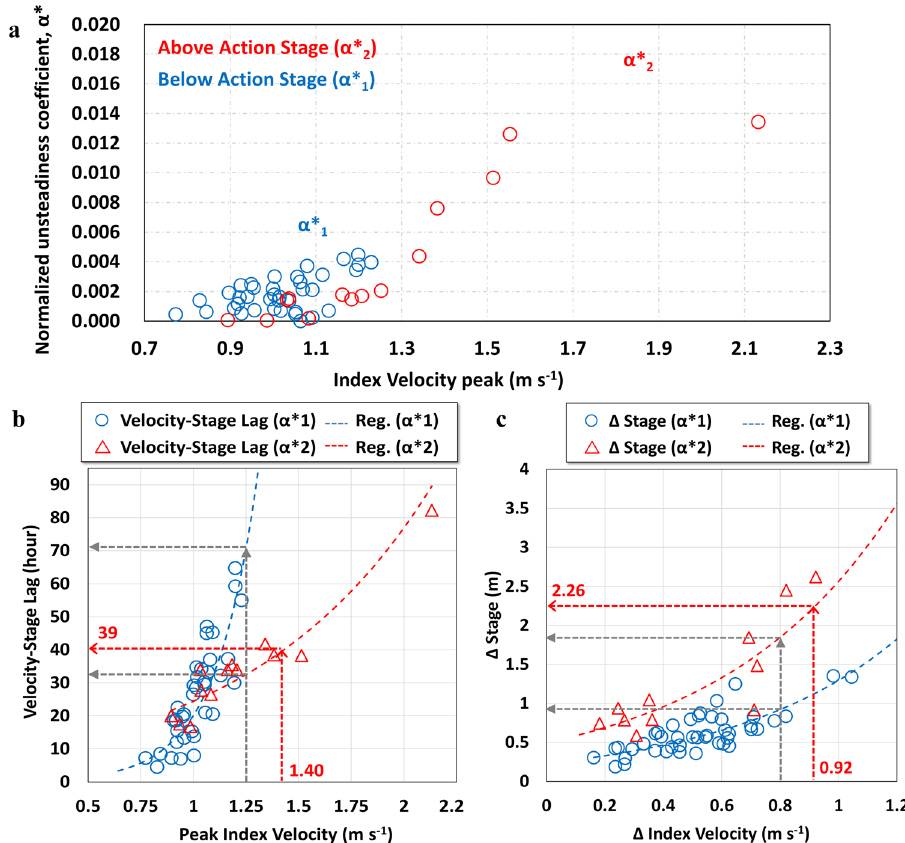
Fig. 4 Construction and usage of the fl ood wave crest amplitude and arrival time forecasting protocol. a Unsteadiness coef fi cients for the pulses in the training dataset grouped by warning severity levels. b Regression lines for the index velocity peak and the corresponding lag times in the stage progression response grouped by warning severity levels. c Regression lines for the gradients of index-velocities and stages to their peaks grouped by warning level severity. Note: red dotted straight lines display forecasted values based on the status of the parameters at the start of storm pulse #50 (see Table 4). Supplementary data to generate Fig. 4 are included in Supplementary Data